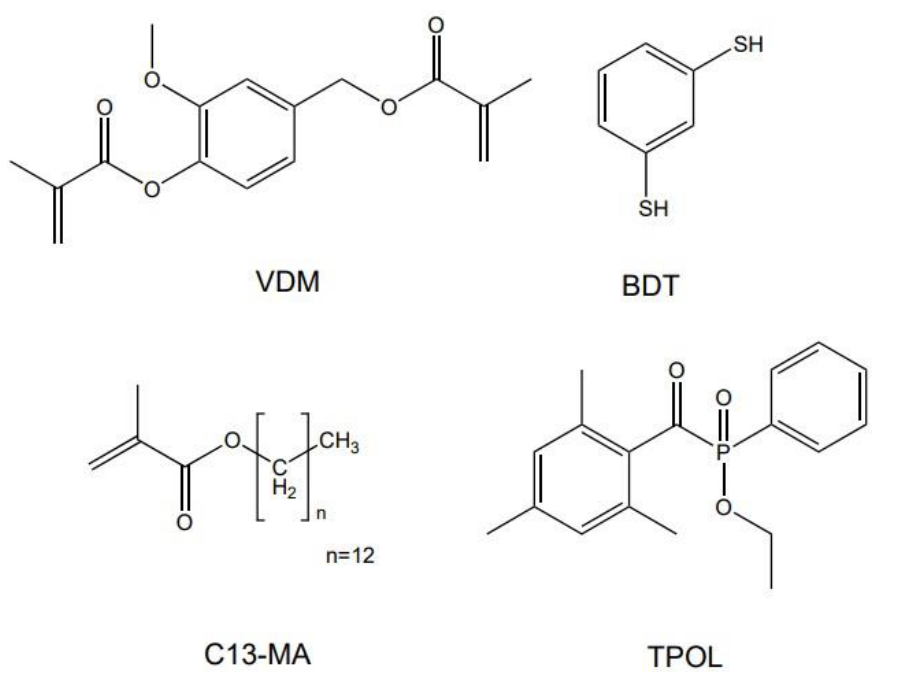
Figure 1. Chemical structures of vanillin dimethacrylate (VDM), 1,3-benzenedithiol (BDT), tridecyl methacrylate (C13-MA), and ethyl(2,4,6-trimethylbenzoyl)phenylphosphinate